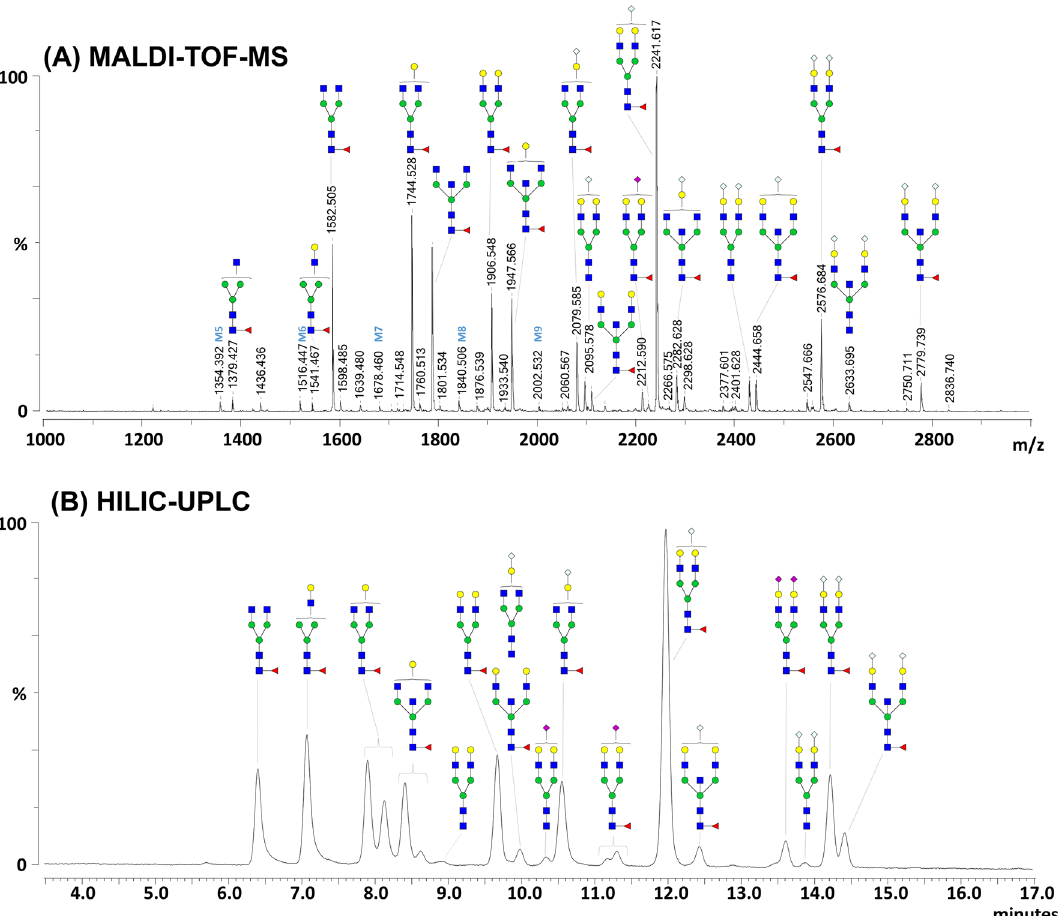
Figure 2. MALDI-TOF-MS analysis and HILIC-UPLC profiling of rhesus macaque IgG N-glycans. PNGase F-released glycans from purified rhesus macaque IgG were labeled with 2-AA and analyzed by MALDI- TOF-MS ( A ) or labeled with procainamide and analyzed using HILIC-UPLC ( B ). N-glycans were subjected to linkage-specific derivatization of the sialic acids by ethyl esterification prior labeling with 2-AA for MALDI- TOF-MS. MALDI-TOF-MS signals were measured in negative ion reflectron mode and are labeled with monoisotopic masses (see Supplementary Table S2 and Fig. S4 online). N-glycan structures were assigned by combining data from both approaches and by using glycosidase digestions as well as MALDI-TOF-MS/MS (see Supplementary Figs. S5 and S6 online). Proposed structures resulting from this analysis are depicted using the CFG nomenclature (see symbol key inset in Fig. 1). M5 to M9 designate mannosylated N-glycans with 5 to 9 mannose 30% of the total N-glycan serum pool is fucosylated in rhesus macaques while it was found to be slightly less than 24% in humans. The abundance of FA2G2S Gc 2 in rhesus macaques largely contributes to this overall higher